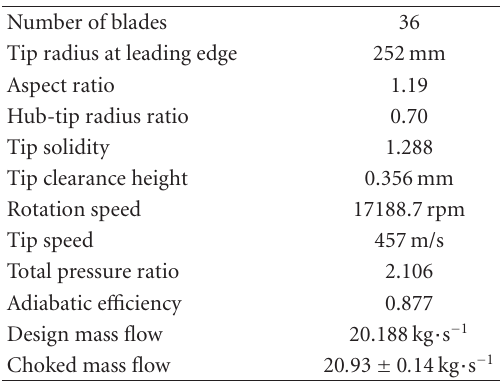
Figure 1: Cross-section of the NASA Rotor 37 [28]. Table 2: Design features of the NASA Rotor 37 [20].